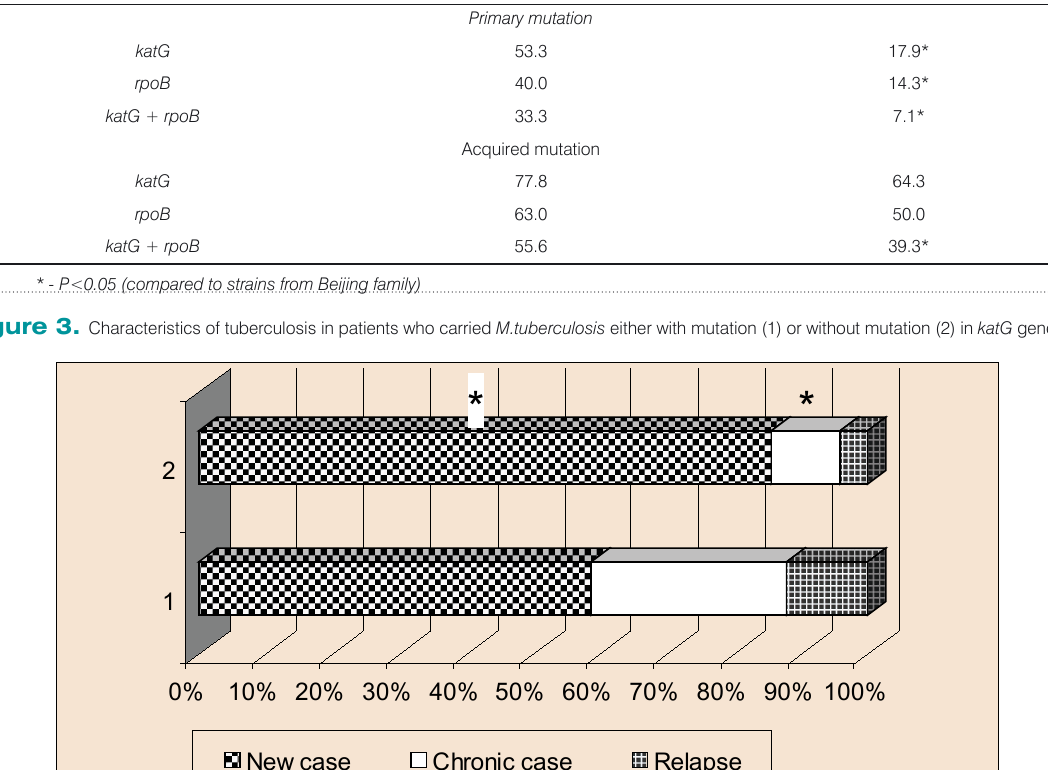
*-P<0.05 relative to patients who carried mutated